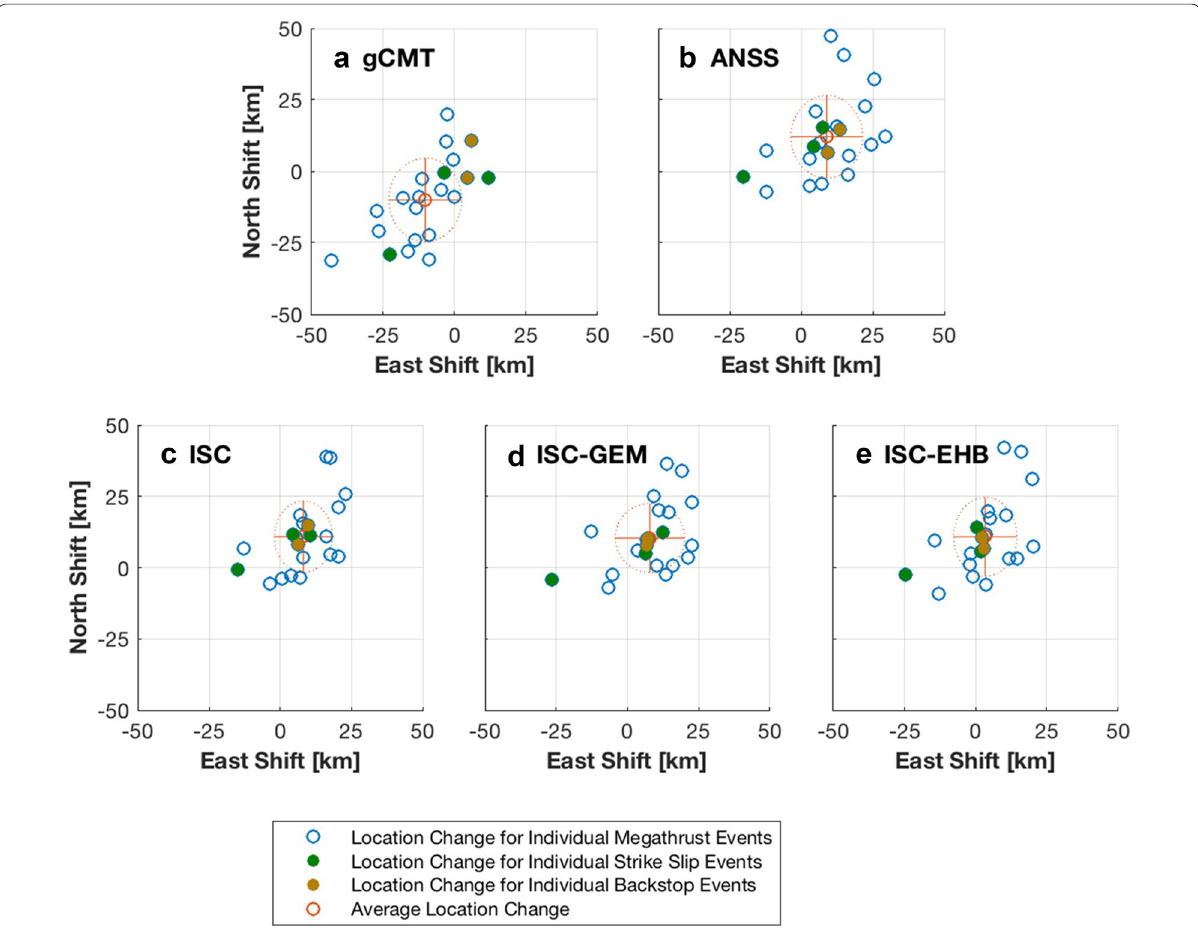
Fig. 5 Location shifts for a gCMT centroids, b ANSS epicenters, c ISC epicenters, d ISC-EHB epicenters, and e ISC-GEM epicenters relative to the centers of our final models. ¯ E and ¯ N show average shifts and their standard deviations in the east–west and north–south directions, respectively. The gCMT centroids are biased toward the southwest with respect to our patch centers, while the ANSS, ISC, ISC-EHB, and ISC-GEM epicenters are biased toward the northeast with respect to our patch